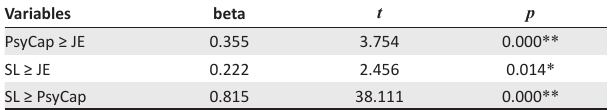
TABLE 6: Path coefficients (inner model).